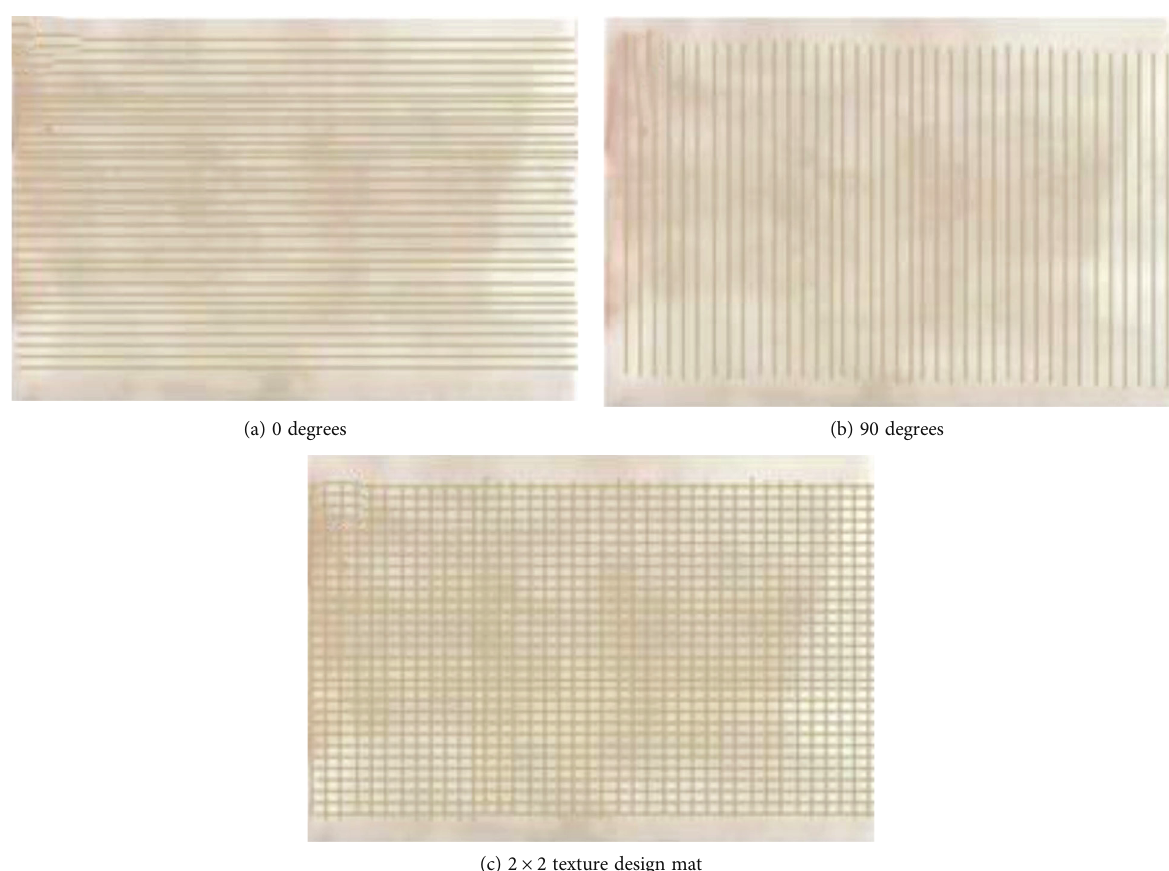
Figure 2: The epoxy composite texture layup design pattern with di ff erent orientations (a) 0 degrees, (b) 90 degrees, and (c) 2 × 2 texture design mat.